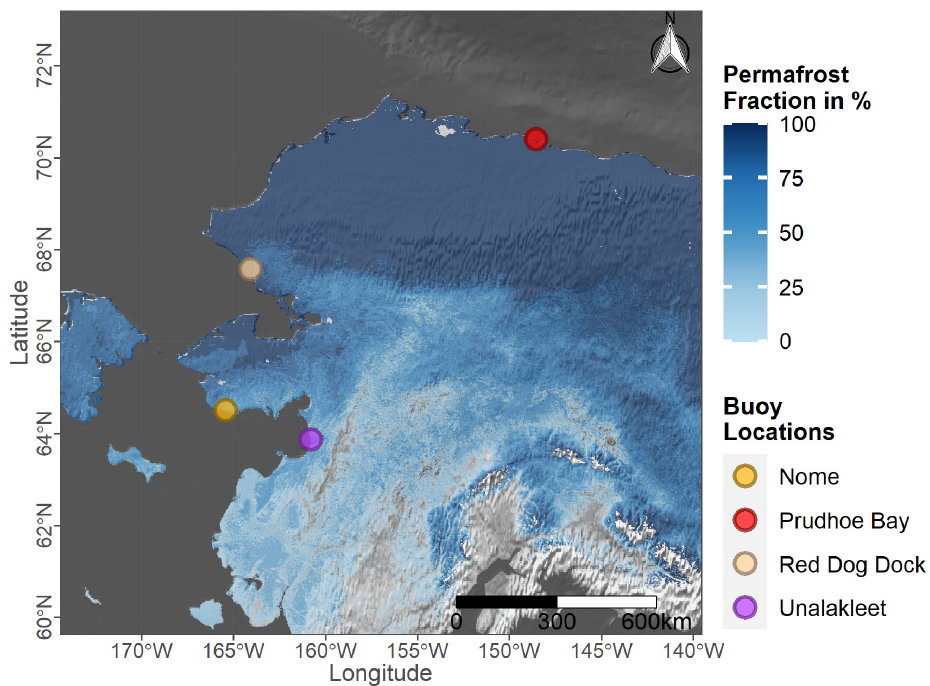
Figure 5. Locations of the buoy stations 9468333 Unalakleet, 9468756 Nome, 9491094 Red Dog Dock, and 9497645 Prudhoe Bay provided by the National Oceanic and Atmospheric Administration (NOAA) [54]. The permafrost fraction across the Northern Hemisphere for the year 2017 based on data by Obu et al. [52] in combination with a shaded relief by Natural Earth [58] was utilized as a background